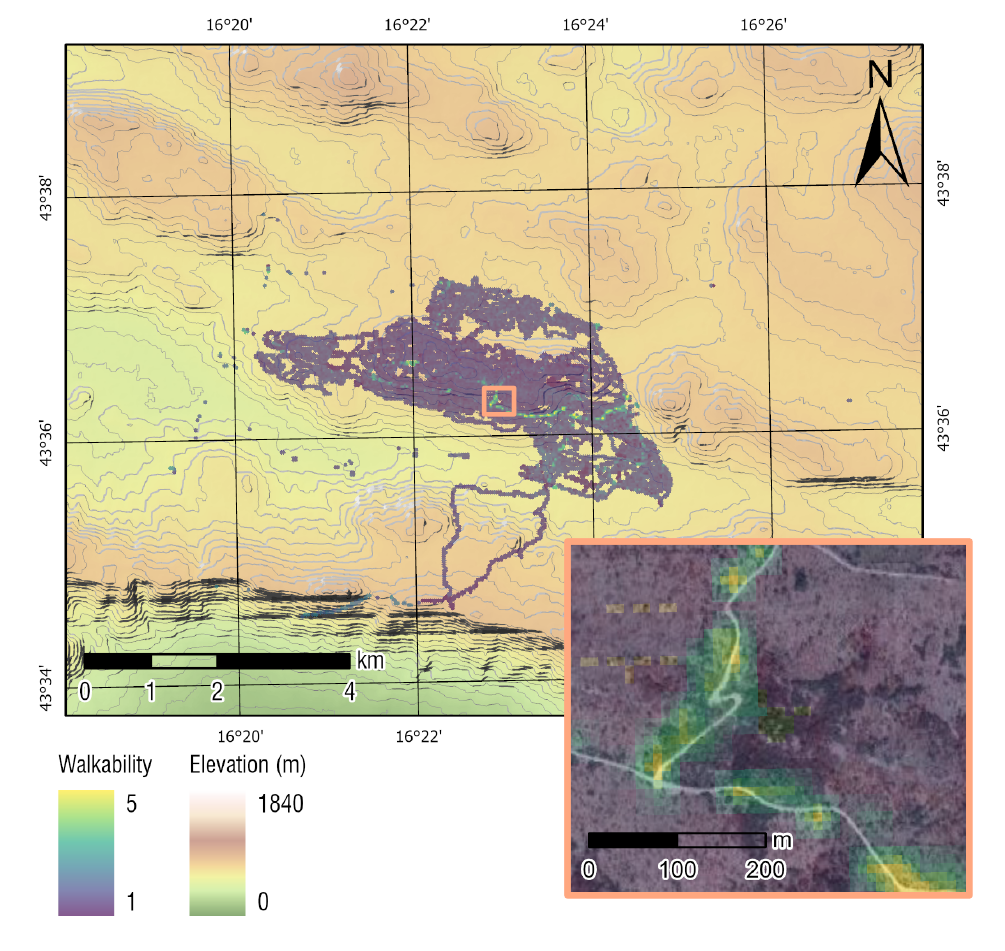
Figure 4: Walkability values shown on